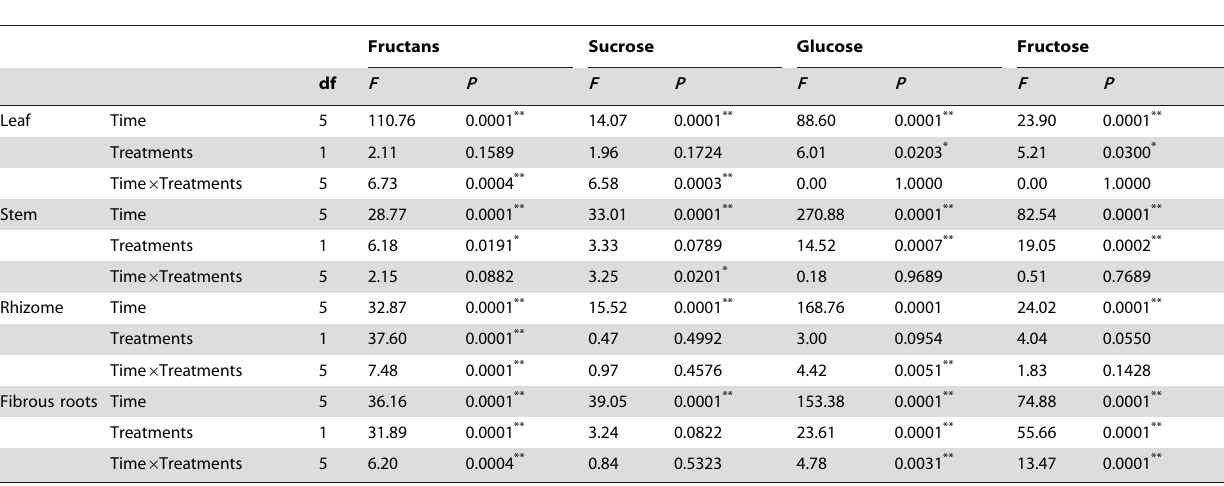
Table 3. Repeated measures ANOVA for between-subject effects, treatments (clipping without and with saliva), and within-subject effects (repeated effects), time, and their interaction effects, time 6 treatments for carbohydrate (fructans, sucrose, glucose and fructose) concentrations of component parts (leaf, stem, rhizome root and fibrous root) of Leymus chinensis